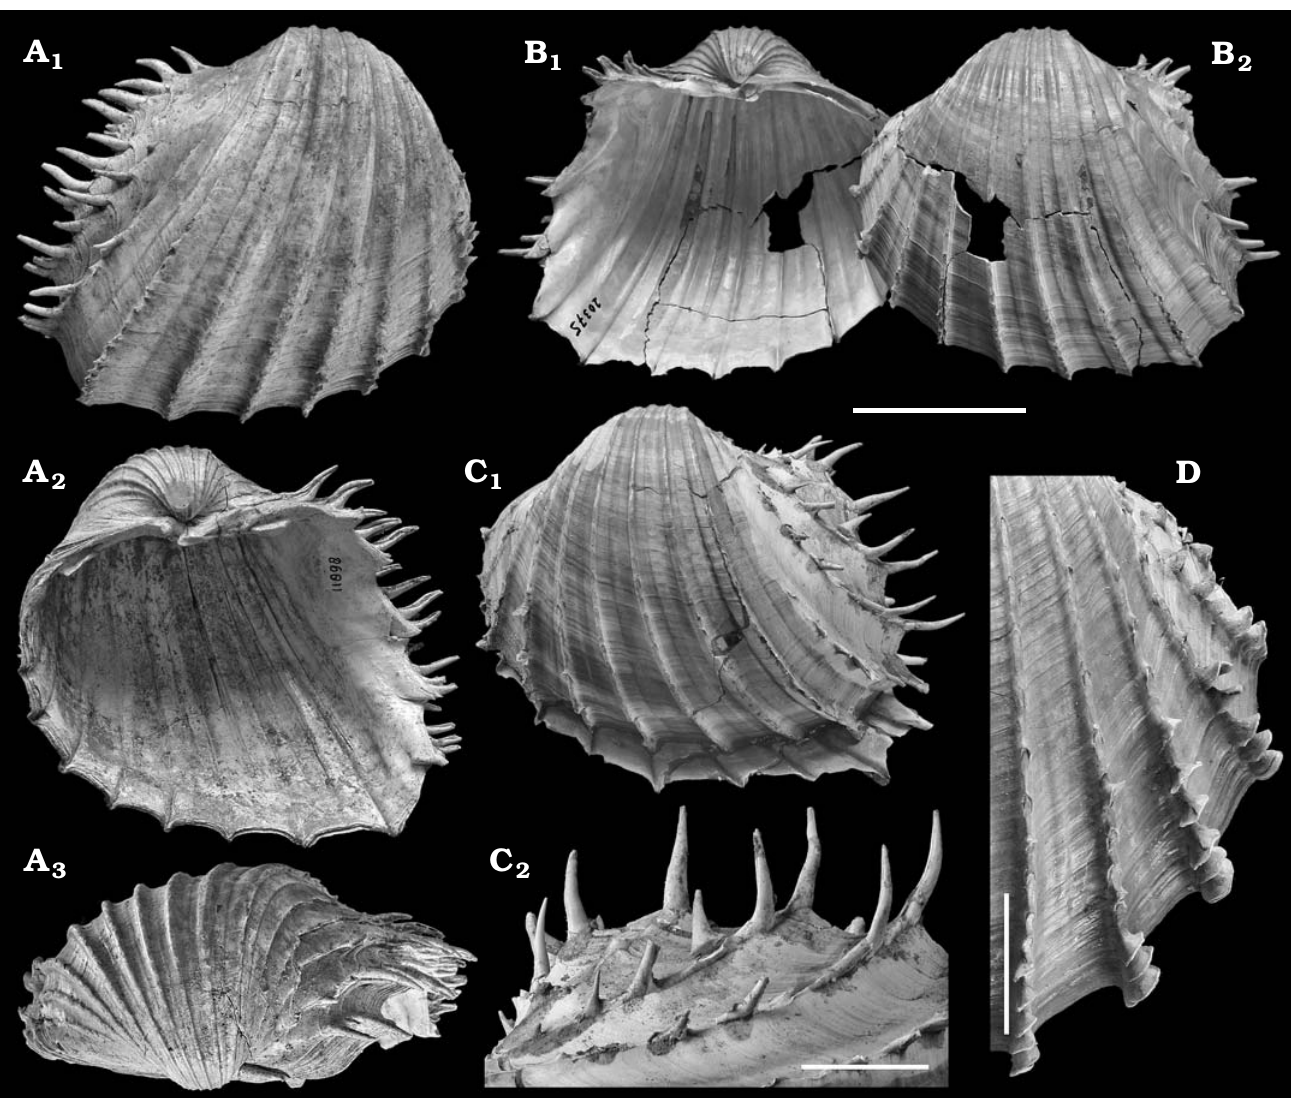
Fig. 8. Cardiid bivalve Procardium kunstleri (Cossmann and Peyrot, 1912) from Serravallian (Miocene) of Salles, France (A) and Tortonian (Miocene) of Cacela Velha, Portugal (B–D). A . PH 11898, external (A 1 ), internal (A 2 ), and umbonal (A 3 ) views. B . PH 20375, internal (B 1 ) and external (B 2 ) views. C . PH 20375, external view (C 1 ) and detail of posterior sculpture (C 2 ). D . PH 20375, detail of anterior sculpture. Scale bars A, B, C 1 , 50 mm; C 2 , D, 20